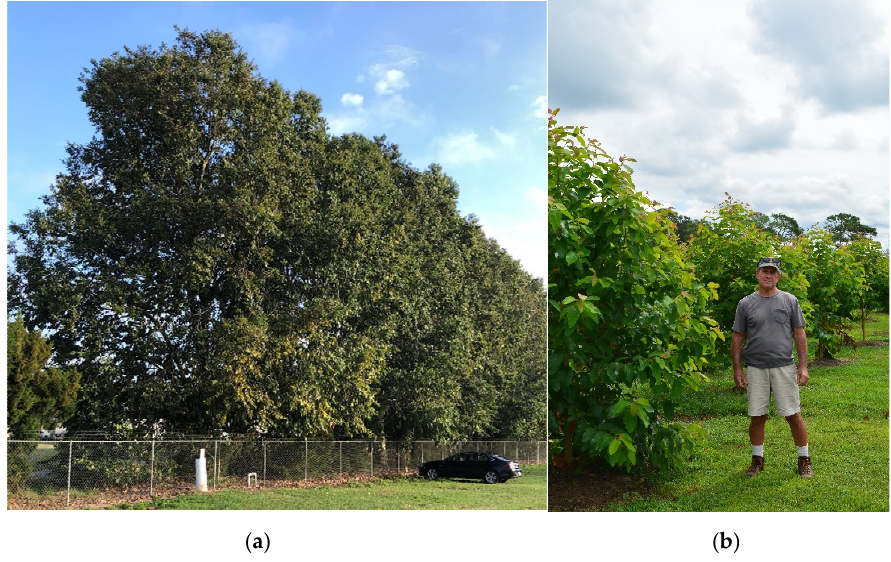
Figure 3. C. torelliana windbreaks in Florida using PRCN potted seedlings: 11-years-old near Frost-